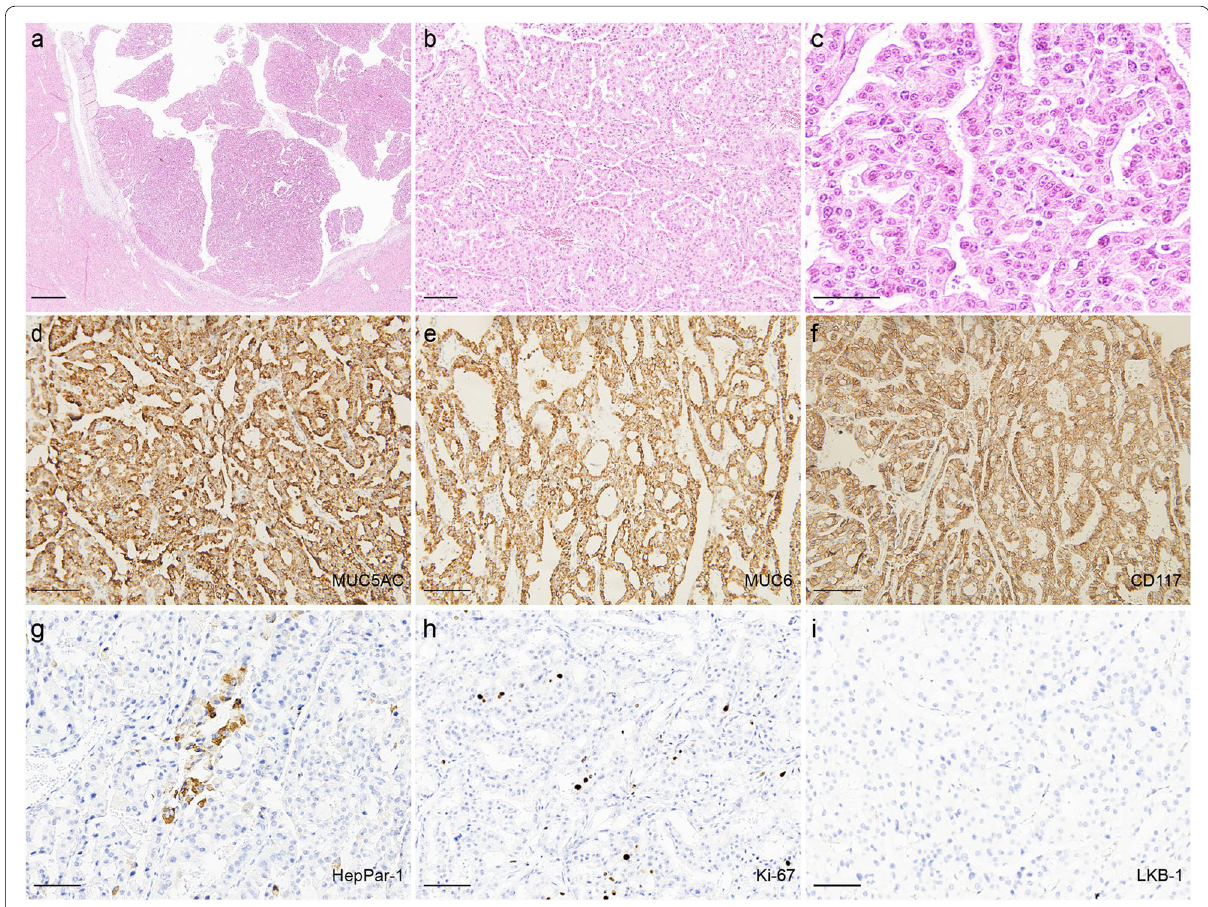
Fig. 2 Histological and Immunohistochemical features of the neoplasm. a The bile duct wall and surrounding liver tissue were not invaded. (Scale bar 1000 μm). b The neoplasm shows complex papillary structures, fine fibrovascular stalks. (Scale bar = abundant eosinophilic granular cytoplasm, round or oval nuclei, clear nucleoli. (Scale bar MUC6 ( e ), CD117 ( f ), HepPar-1 ( g ) and the Ki-67 ( h ) index is relatively low. (All scale bars (Scale bar 100 =